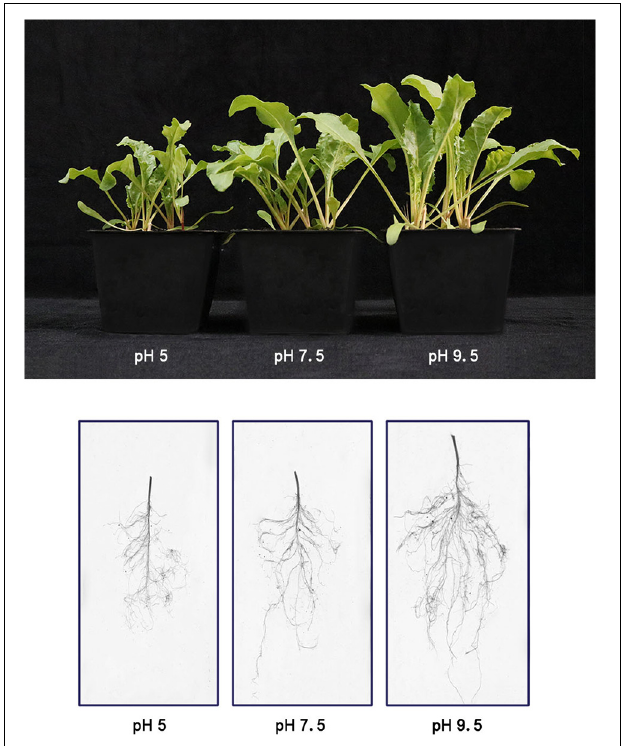
FIGURE 1 | The phenotype and growth status of sugar beet in three pH